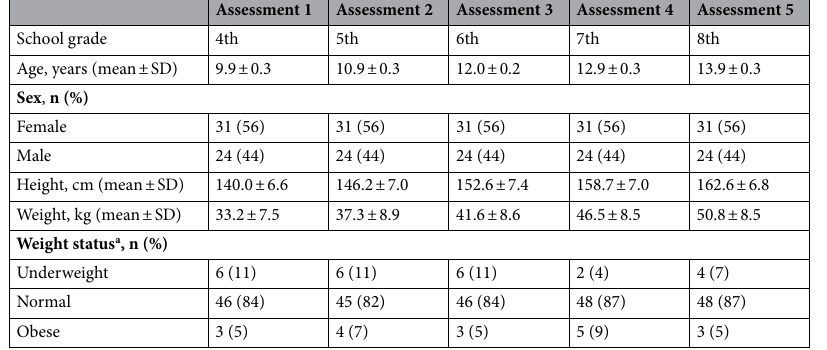
Table 1. Descriptive statistics of participants (n = 55) in each assessment of this five-year longitudinal study on physical activity in children transitioning from primary to secondary school. SD standard deviation. a Weight status refers to the percentage of overweight, calculated as the ratio of weight to the expected standard weight according to sex, age, and